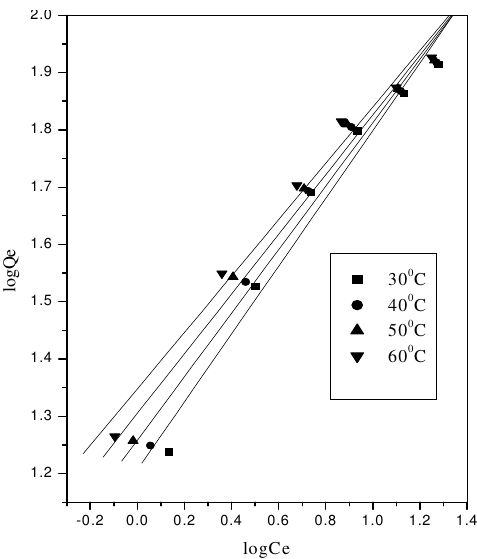
Figure 4 . Linear Freundlich isotherm for the adsorption of RDB by